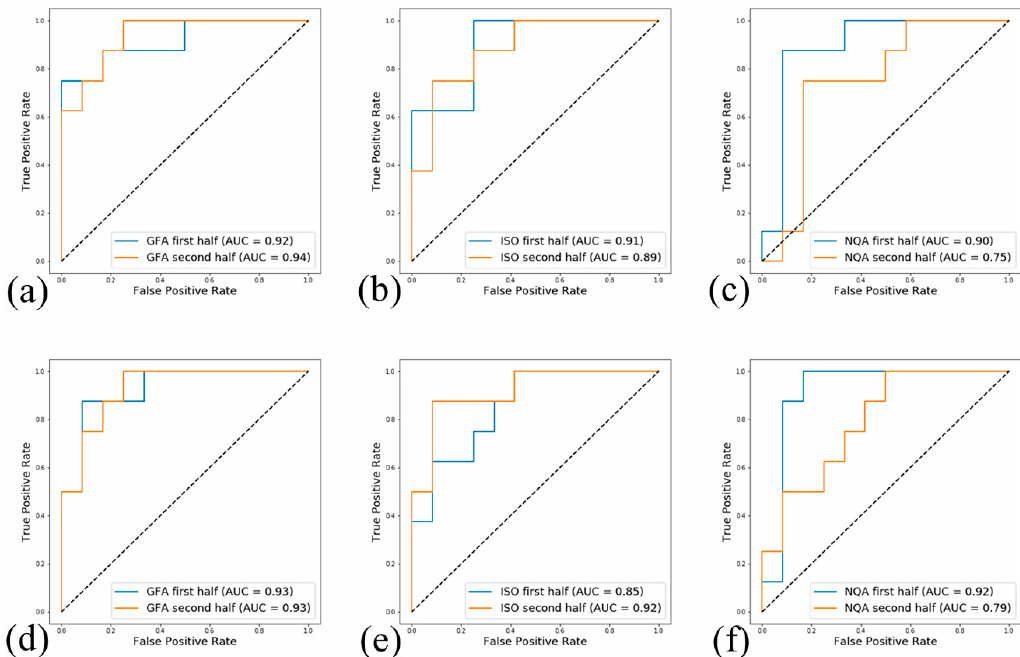
Figure 2. The testing set classification receiver operating characteristic (ROC) curves showing the best results of ( a ) extreme gradient boosting (XGB)- generalized fractional anisotropy (GFA), ( b ) XGB- isotropic value of the orientation distribution function (ISO), ( c ) XGB- normalized quantitative anisotropy (NQA), ( d ) logistic regression (LR)-GFA, ( e ) LR-ISO, and ( f ) LR-NQA following autoencoder and supervised machine learning analysis, along with the area under curves (AUCs) (AUC: XGB-GFA-1 = 0.92; XGB-GFA-2 = 0.94; XGB-ISO-1 = 0.91; XGB-ISO-2 = 0.89; XGB-NQA-1 = 0.90; XGB-NQA-2 = 0.75; LR-GFA-1 = 0.93; LR-GFA-2 = 0.93; LR-ISO-1 = 0.85; LR-ISO-2 = 0.92; LR-NQA-1 = 0.92; LR-NQA-2 = 0.79).